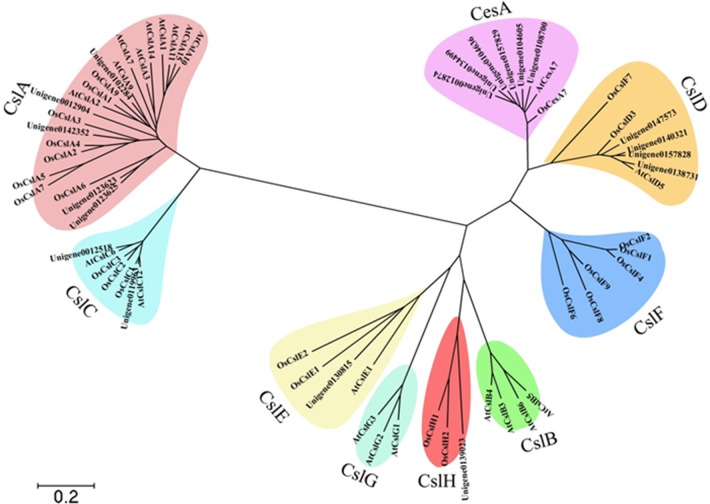
Molecular phylogenetic tree of the amino acid sequences of the CesA superfamily of D. officinale, A. thaliana, and O. sativa. The tree was constructed using MEGA 4 by the neighbor-joining method. The tree was displayed as a phylogram in which branch lengths are proportional to distance. Bootstrap values for 1000 replicates were used to assess the robustness of the trees. The amino acid sequences of A. thaliana and O. sativa used for alignment are as follows: AtCesA7, gb|AAD32031.1|; AtCslA1, gb|AAO42230.1|; AtCslC12, gb|AAD15482.1|; AtCslG2, gbAAB63623.1|; AtCslA7, gb|AAL24081.1|; AtCslG3, gb|AAB63624.1|; AtCslG1, gb|AAB63622.1|; AtCslA15, gb|AEE83276.1; AtCslC6, gb|AAF02144.1|; AtCslD5, gb|AAF02892.1|; AtCslA3, gb|AAF79586.1|; AtCslB6, gb|AEE83584.1|; AtCslB5, gb|AAQ22621.1|; AtCslA9, gb|AAL31192.1|; AtCslA14, gb|AAO42815.1|; AtCslB4, gb|AAC25936.1|; AtCslB3, gb|AAC25935.1|; AtCslE1, gb|AAF79313.1|; AtCslA10, gb|AAF87149.1|; AtCslA2, gb|AAL24334.1|; AtCslA11, gb|AED92259.1|; OsCslA6, gb|AAL25127.1|; OsCslF1, gb|AAL25131.1|; OsCslE2, gb|AAL25130.1|; OsCslA9, gb|AAL25128.1|; OsCslA3, tpg|DAA01744.1|; OsCslD3, tpg|DAA01756.1|; OsCslC2, tpg|DAA01750.1|; OsCslF7, gb|AAK91320.1|; OsCslA2, gb|AAK98678.1|; OsCslF2, gb|AAL25132.1|; OsCslA5, gb|AAL82530.1|; OsCslA4, gb|AAL84294.1; OsCslH2, dbj|BAF14725.2|; OsCslC1, dbj|BAC10759.1|; OsCslH1, gb|AAN01252.1|; OsCslA7, gb|ABG34297.1|; OsCslF8, dbj|BAC65371.1|; OsCslF9, dbj|BAC80027.1|; OsCslF6, dbj|BAC66734.1|; OsCslD3, dbj|BAD01697.1|; OsCslF4, dbj|BAC83321.1|; OsCslC3, dbj|BAC98512.1|; OsCslA1, tpg|DAA01743.1|; OsCslE1, dbj|BAD46389.1|; OsCesA7, gb|AAK27814.1|.